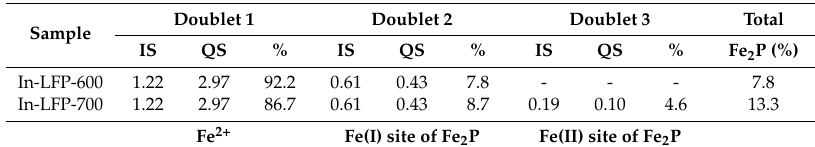
Table 2. Room temperature Mossbauer parameters of In-doped LiFePO 4 /C samples annealed at 600 ◦ C and 700 ◦ C.